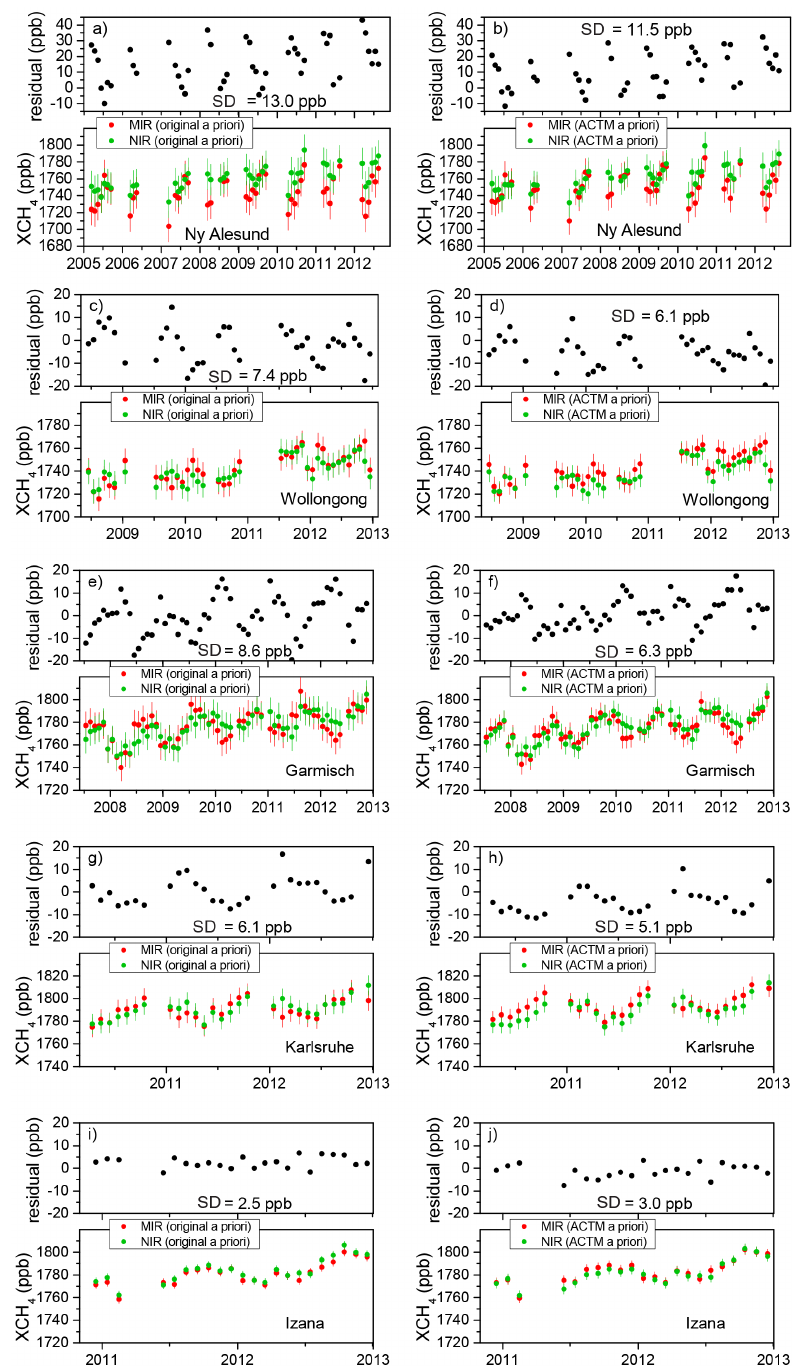
Figure 2. (a) Lower trace: monthly-mean MIR and NIR time series for Ny-Ålesund. Both column series are plotted as retrieved with their original retrieval a priori profiles. Error bars are 2 σ uncertainties as explained in Fig. 1. Upper trace: residual time series; i.e., difference time series of the NIR and MIR data shown in the lower trace. (b) Same as (a) but using for Ny-Ålesund a correction to 3-hourly ACTM profiles as common prior, (c) for Wollongong the original retrieval a priori profiles, (d) for Wollongong a correction to ACTM, (e) for Garmisch the original retrieval a priori profiles, (f) for Garmisch a correction to ACTM, (g) for Karlsruhe the original retrieval a priori profiles, (h) for Garmisch a correction to ACTM, (i) for Izaña the original retrieval a priori profiles, and (j) for Izaña a correction to